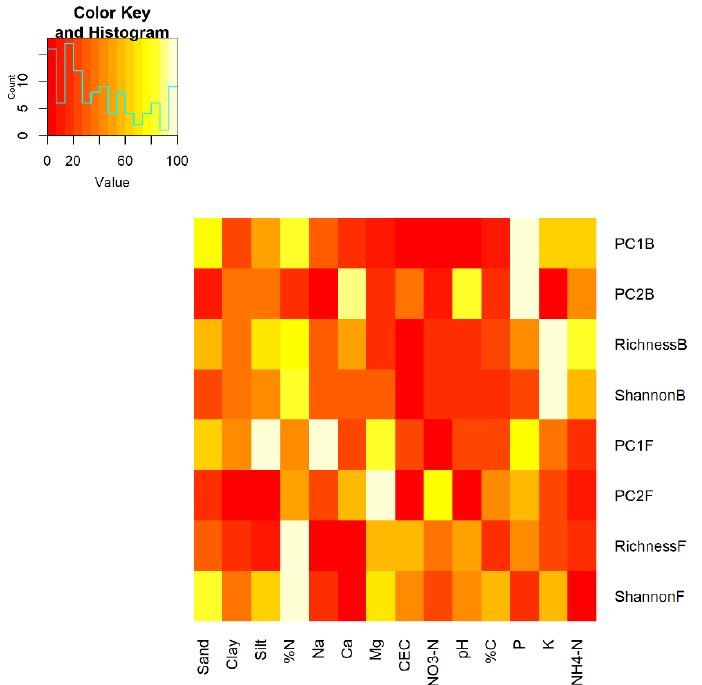
Figure 5. Heatmap showing variable importance according to stepwise regression analysis of soil physicochemical parameters affecting microbial diversity and community composition. Brighter colors indicate more important variables in the final regression model, with colors mapped to a variable importance scale of 0–100 (see histogram in upper left). Stepwise regression was implemented with 10-fold cross-validation. CEC: cation exchange capacity; PC1: first eigenvector of community composition; PC2: second eigenvector of community composition; B: bacteria; F: fungi.